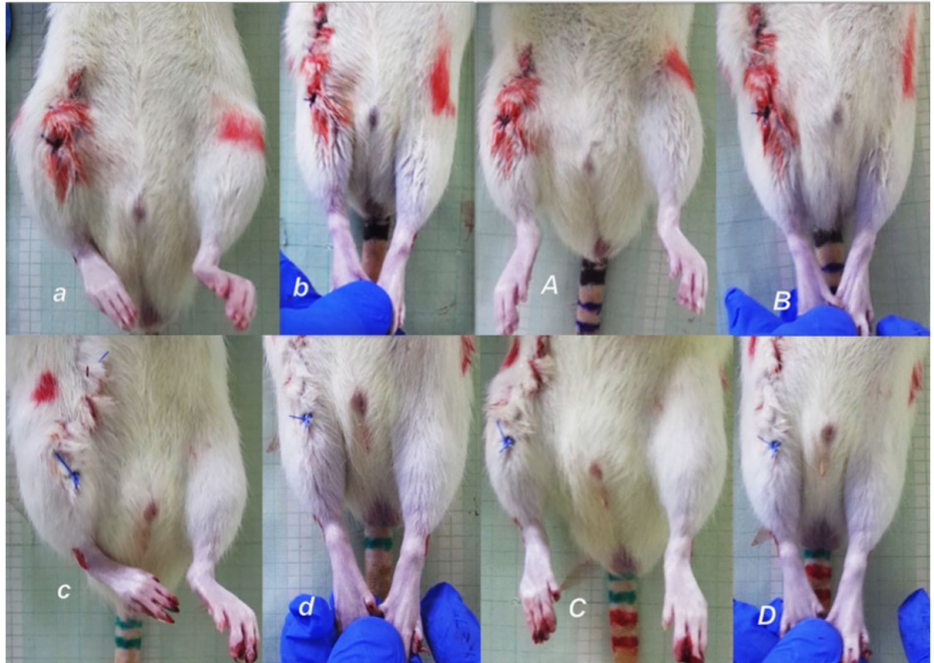
Figure 3. To assess immediately following post-operative recovery, and to ensure consistency of injury based on this expected deficit in motor function, at 2 h post-injury, close to the end of the anesthesia period, rats, held upright, exhibit the spontaneous injured leg contracture ( a , c ) that was demonstrated upon leg extension ( b , d ). Upon BPC 157 10 ng/kg given intragastrically ( A , B ), leg contracture disappears, in spontaneous presentation ( A ), or upon maximal legs extension ( B ). Contrarily, the leg contracture remains unchanged in the controls (water (1 mL/rat) given intragastrically) ( C , D ).